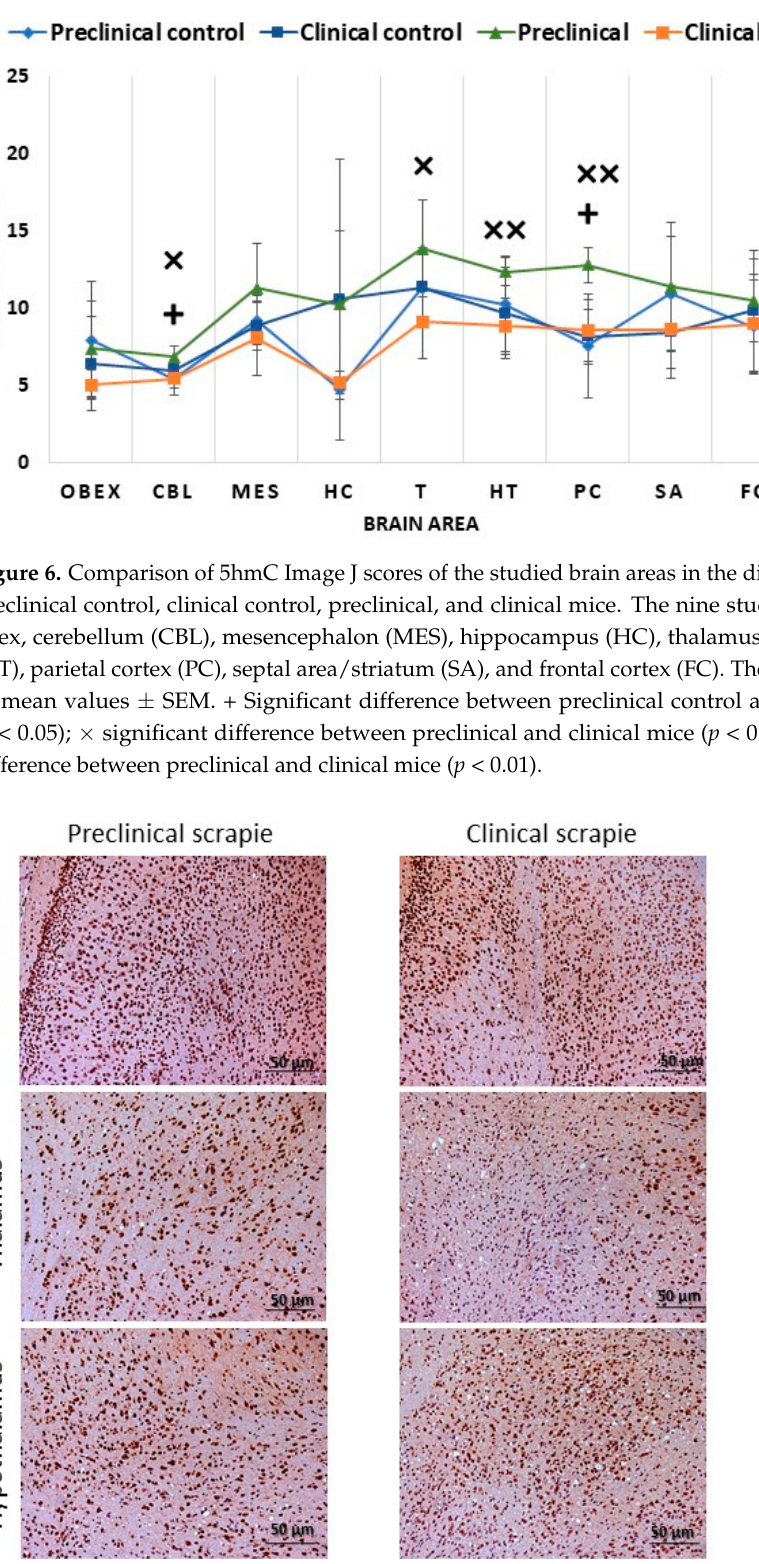
Figure 7. Immunostaining patterns of 5hmC in the parietal cortex, thalamus, and hypothalamus of preclinical and clinical Tg338 mice.